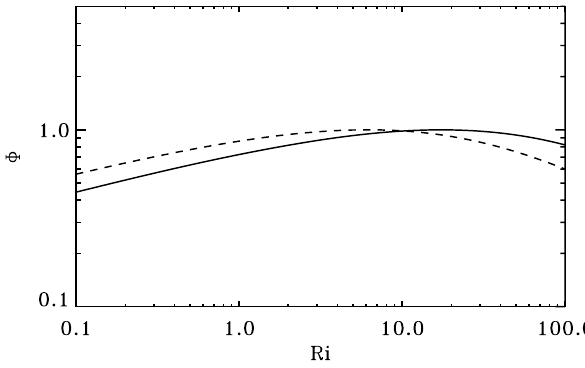
Fig. 5. Same as Fig. 4 but with two different values of the parameter C =3 (dashed), 6 (solid) to show the weak dependence on such a